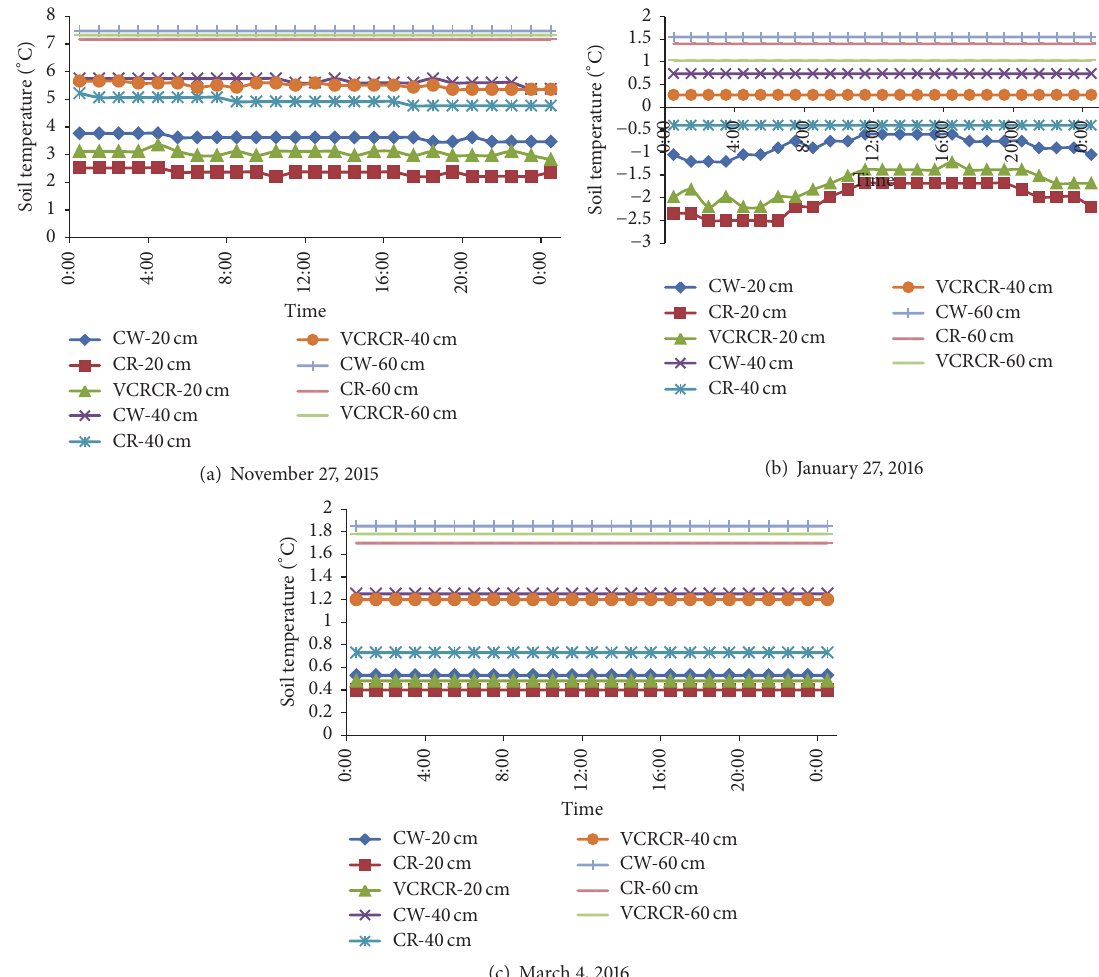
Figure 6: Temporal soil temperature changes in different soil depth under different postsowing compaction treatments during wintering period.